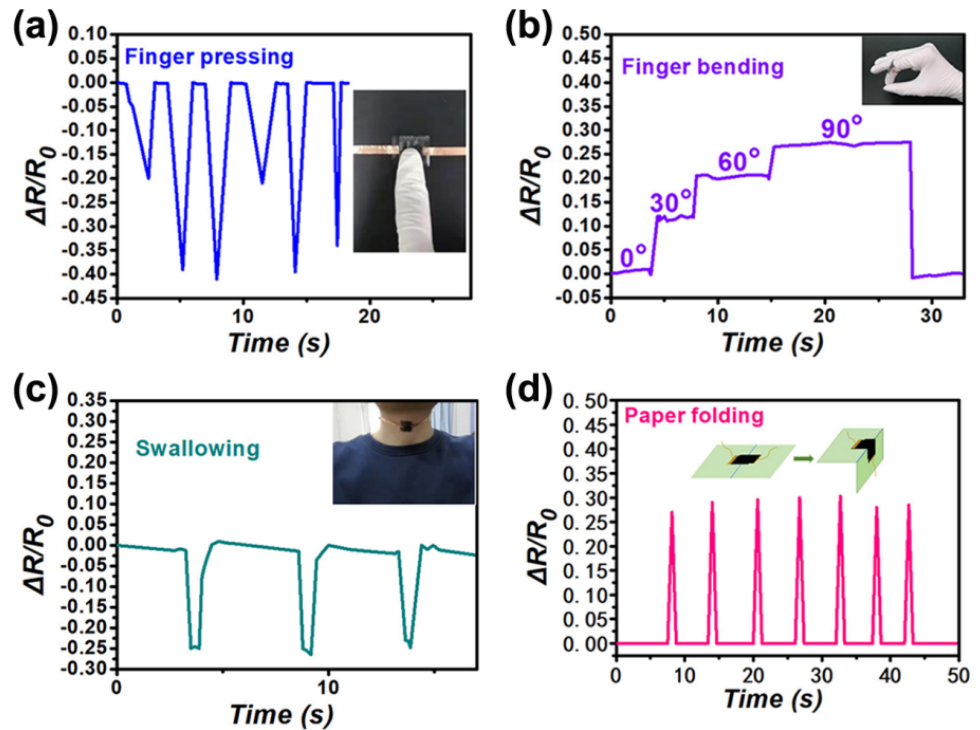
Figure 5. ( a ) The measurement of a finger pressing, inset: photo of finger pressing pressure sensor; ( b ) finger bending produces responsive curves (0°, 30°, 60°, and 90°), illustration: photo of pressure sensor fixed to finger; ( c ) detection of motion in the human larynx during swallowing; ( d ) the sensor’s resistance varies when it is fixed in the folds of cardboard.